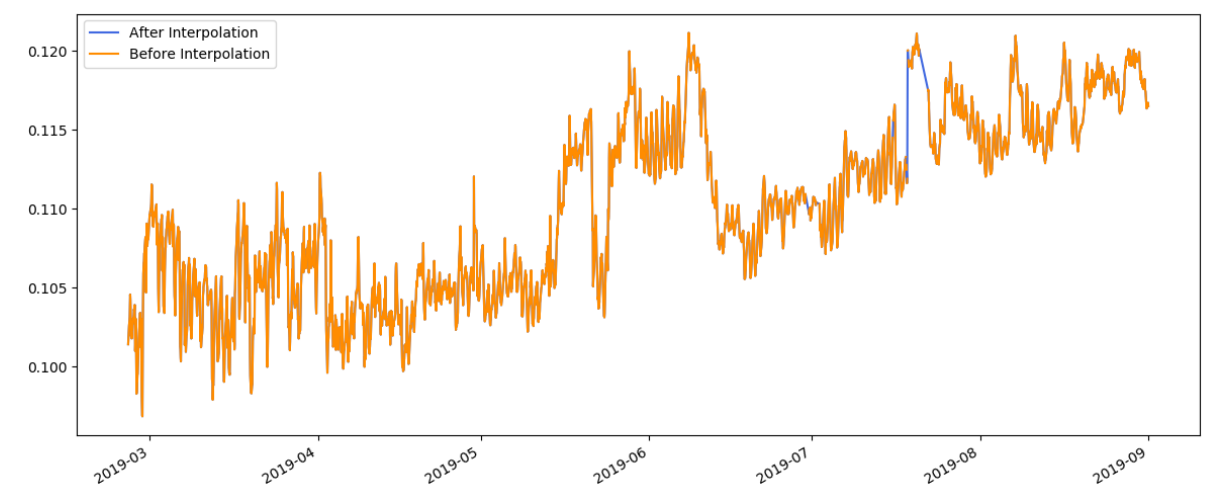
Figure 2. Preprocessed data: the blue line shows the data points after linear interpolation filled the gap of missing values in the Crack A1 data.